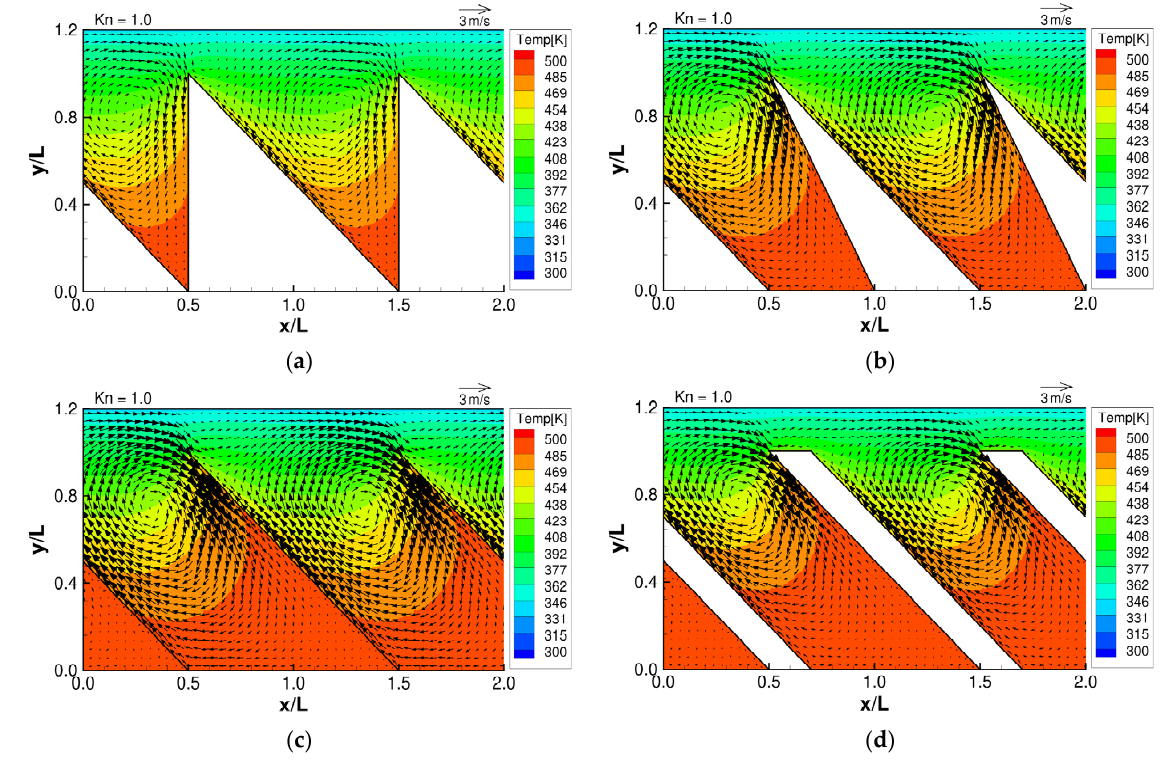
Figure 4. Flow distributions and temperature distributions for ( a ) ratchet, ( b ) modified ratchet, ( c ) oblique plate, and ( d ) oblique ridge, at Kn = 1 .